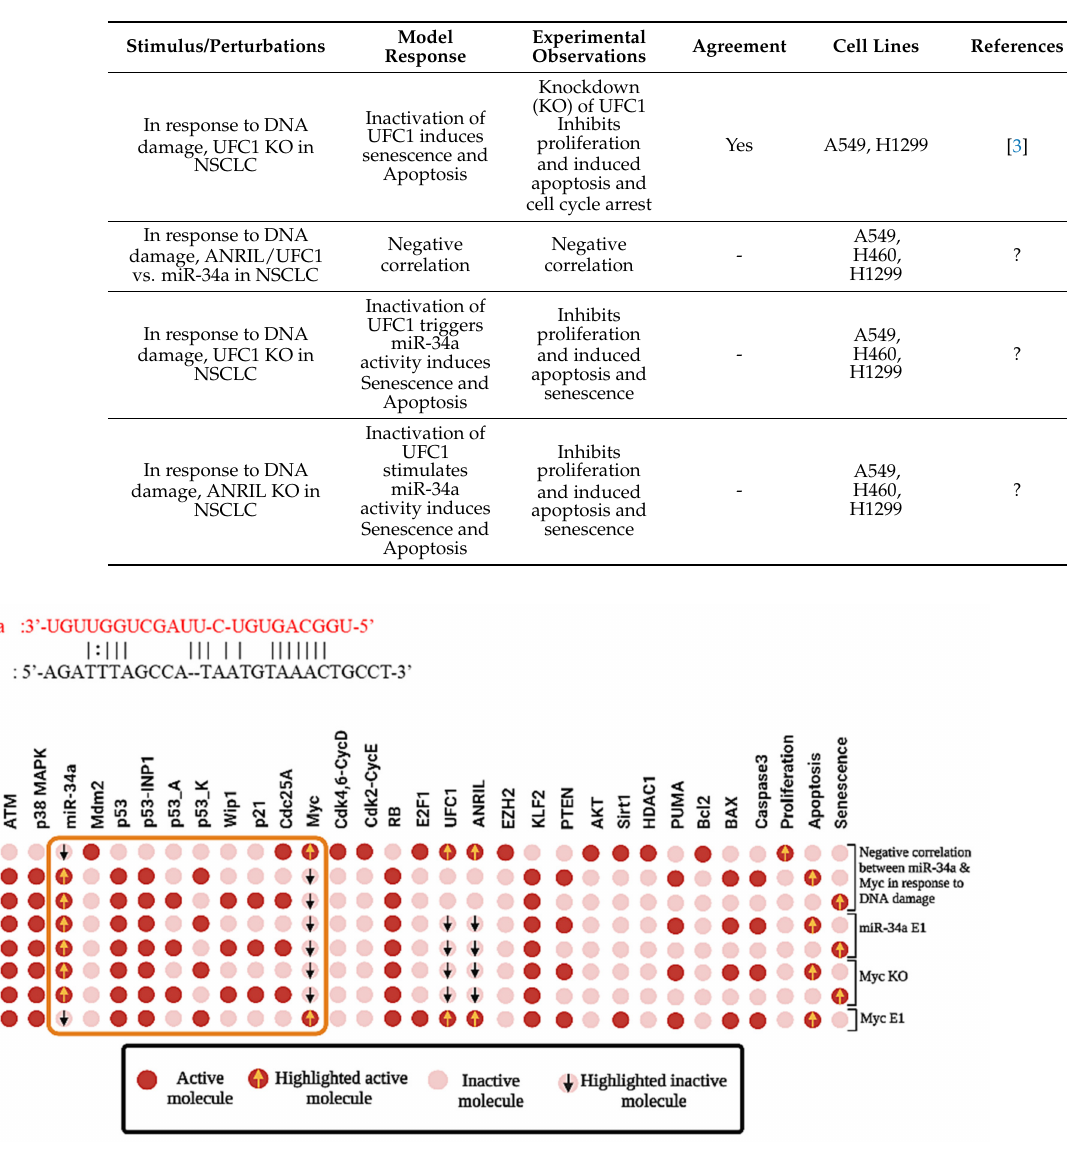
Figure 4. Duplex structure of miR-34a and model perturbations. ( A ) Binding site between miR-34a and Myc. ( B ) Perturbations of miR-34a & Myc in response to DNA damage, miR-34 E1, Myc KO and Myc E1. Gain-of-function (GoF) and loss-of-function (LoF) perturbations corresponding to knockdown (KO) and overexpression (E1) of their referential experiments (He et al. [6]). The leftmost column shows the DNA damage level (highlighted in the black box) and the rightmost column presents the model outputs, including proliferation, senescence, and apoptosis. Each line represents a fixed point corresponding to the input. Each cell/dot or circle represents a molecule. Light red cells indicate a value of zero, whereas red indicates activation (value 1). Activity of miR-34a on the Myc expression as suggested by [6] (highlighted in the orange box). Orange- arrows indicate up-regulation of the molecule, whereas the inverted black arrow represents the downregulation of the molecule,